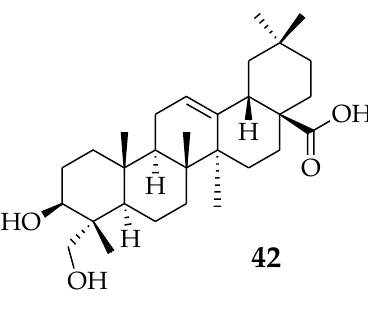
Figure 12. Hederagenin. Figure 12.